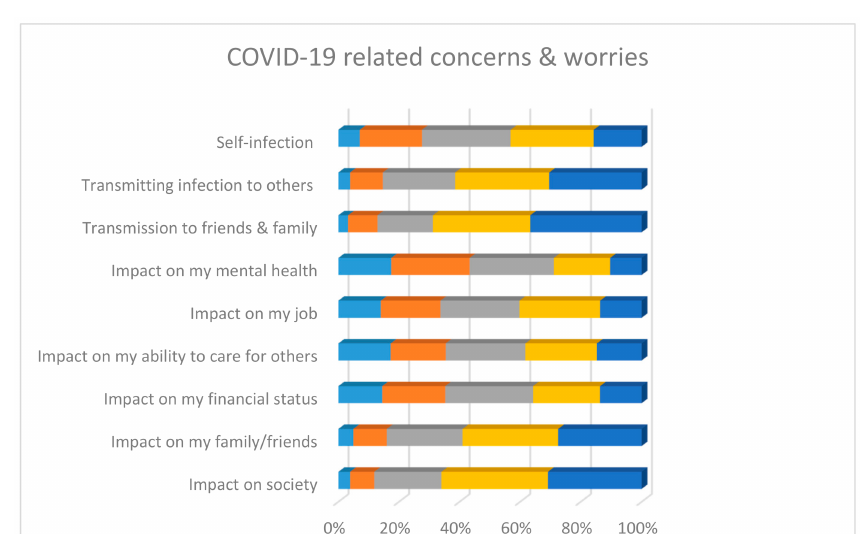
Figure 1. COVID-19 related self-reported concerns about risk of infection and impact of pandemic.